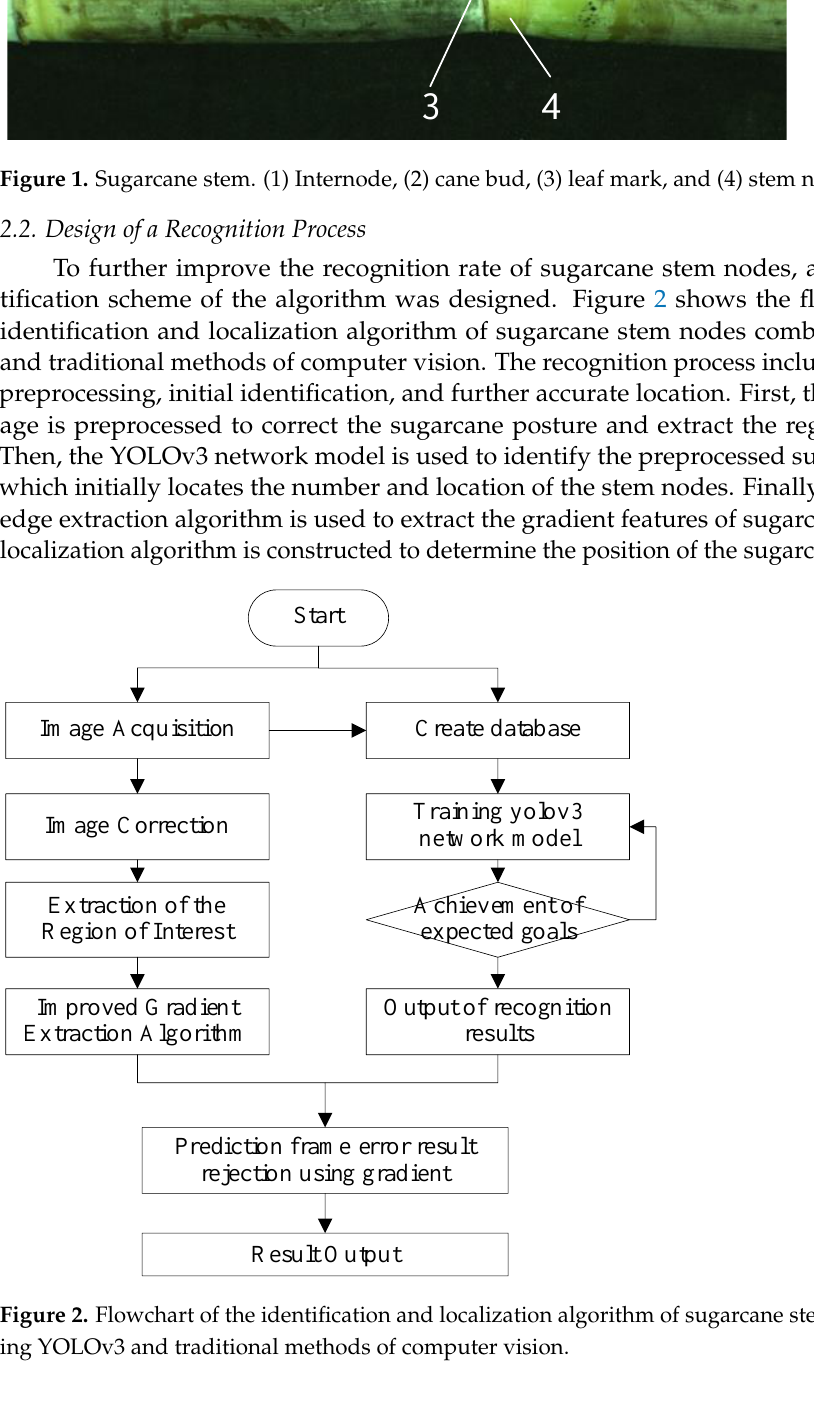
Figure 1. Sugarcane stem. (1) Internode, (2) cane bud, (3) leaf mark, and (4) stem node.